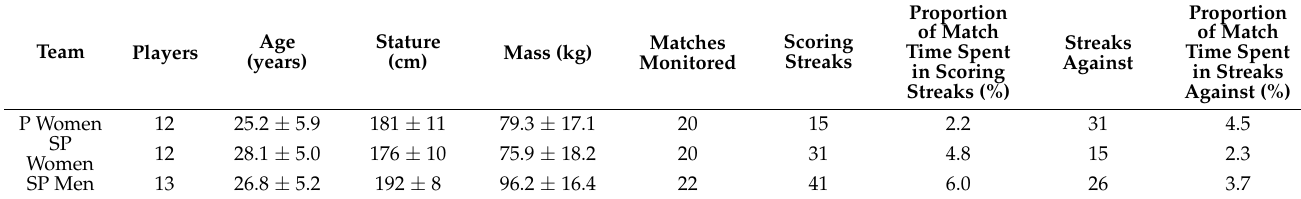
Table 1. Participant